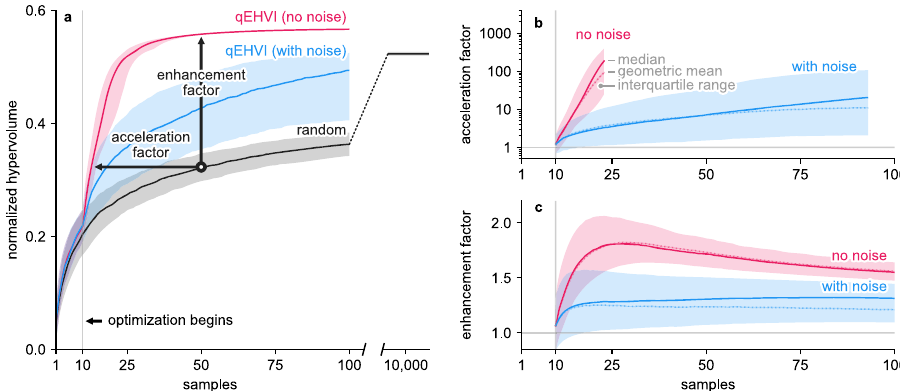
Fig. 4 Quanti fi cation of the bene fi t provided by the qEHVI algorithm in simulated optimization campaigns. a The hypervolumes achieved by the simulated qEHVI and random searches. The median (solid line) and interquartile range (shaded bands) of the results are shown for simulations with and without simulated experimental noise. b The acceleration factors for the qEHVI algorithm relative to random search. The geometric mean is also shown (dashed line). c The enhancement factor for the qEHVI algorithm relative to random search.